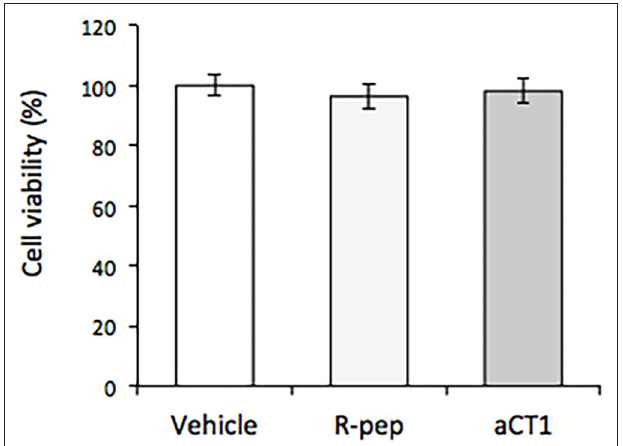
FIGURE 4 | Effect of combination treatment of BBI and aCT1 peptide on cell viability in TLM1 cells. The cells were treated with 400 µ g/ml BBI and 200 µ M aCT1 (or R-pep) for 5 days. Cell viability was evaluated by a PrestoBlue assay. Columns represent means ± standard deviations ( n = 6). * p < 0.05, ** p < 0.01, *** p < 0.001, using Tukey’s